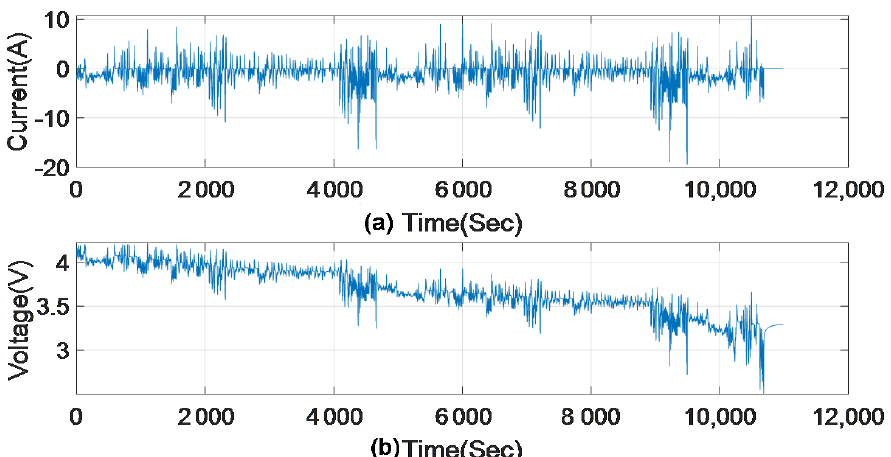
Figure 3. Experimental data for model estimation (MIX driving cycle): ( a ) Current; ( b ) Voltage [37].